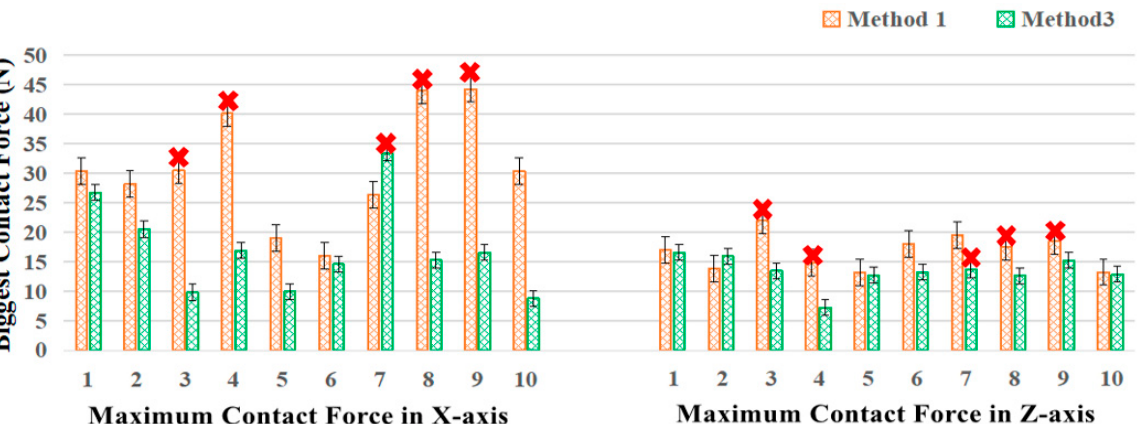
Figure 15. The max contact force in the X and Y axes of ten tests controlled by two methods. Method 1 representatives the master–remote position controller; method 2 represents the designed inte- grated position/force control method. Those red “ × ” indicate that in this experiment, the remote robot stopped for protection due to excessive contact force.